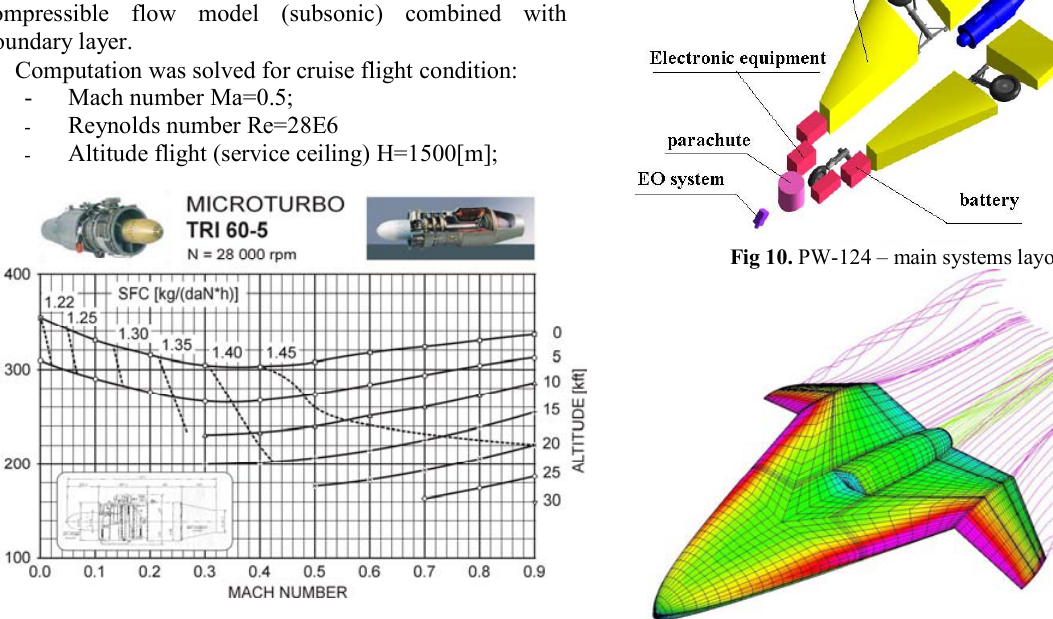
Fig 8. TRI 60-5 TurboJet engine was selected due to its high longitudinal load factor C. Wing